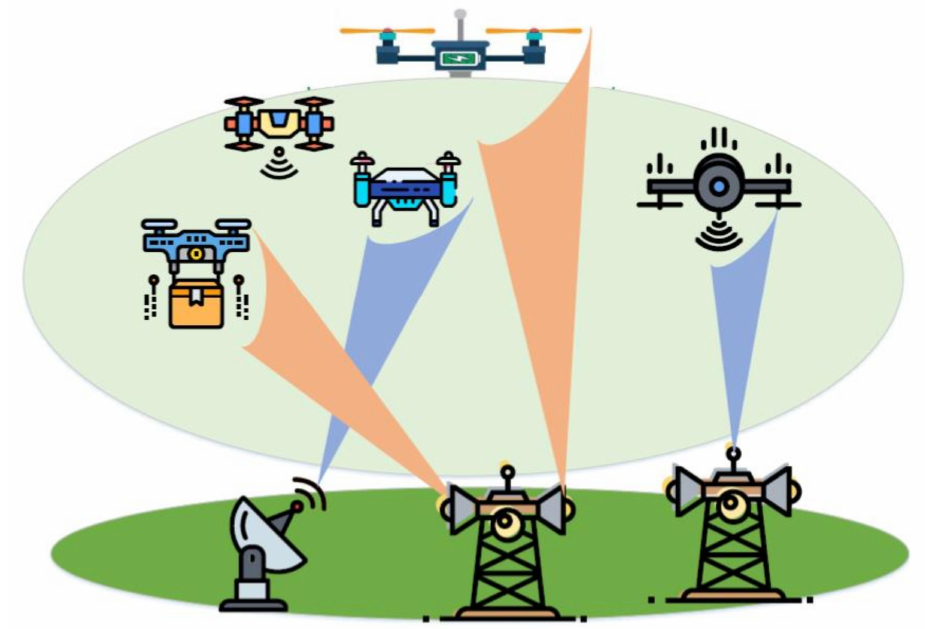
Figure 10. Recharging of multiple UAVs through laser beams